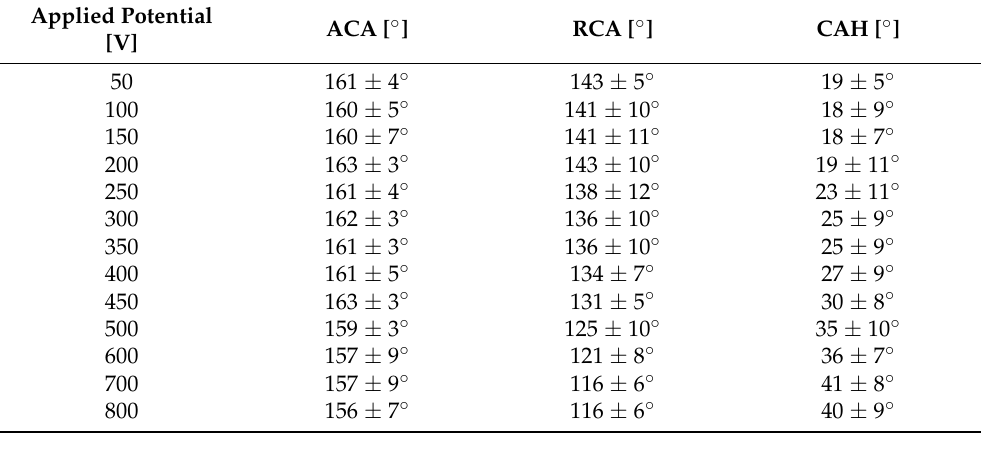
Table A2. Measured advancing (ACA) and receding (RCA) CAs and subsequent calculated CA hysteresis (CAH) in dependence of the applied potential.